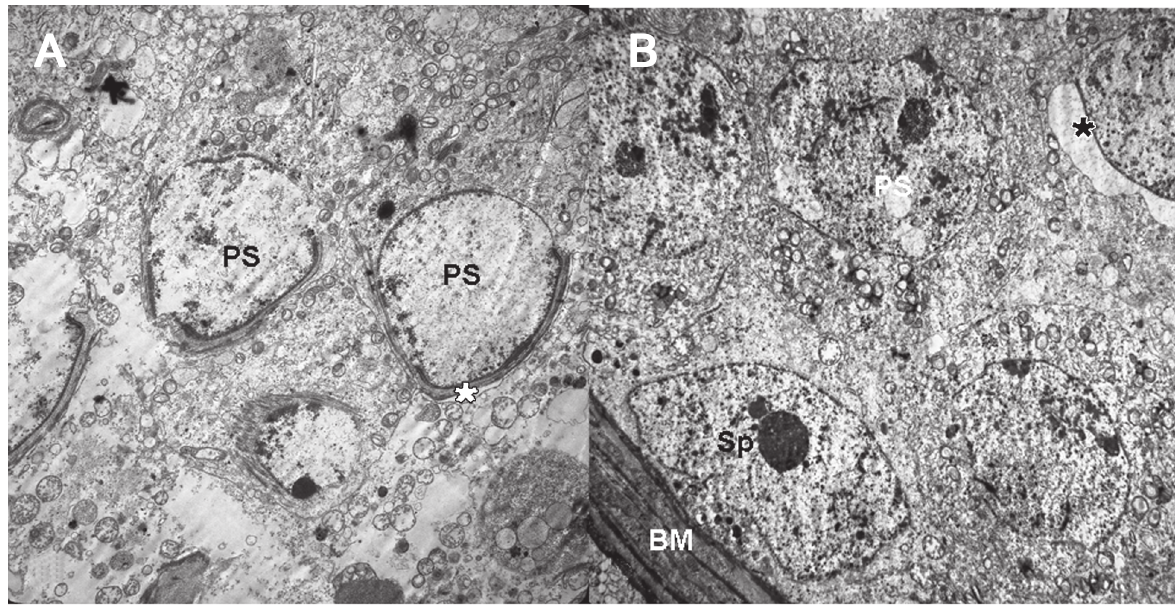
Figure 4. Electron micrograph of the group submitted to abdominopelvic irradiation + melatonin administration. Panel A, In tissue samples obtained in the morning, primary spermatocytes show normal structure (PS), with some disconnecting areas between them (asterisk). Panel B, Tissue samples obtained in the evening are similar to control samples, with spermatogonia (Sp), primary spermatocytes (PS), acrosomal caps (asterisk), and basement membrane (BM) (uranyl acetate and lead citrate staining,